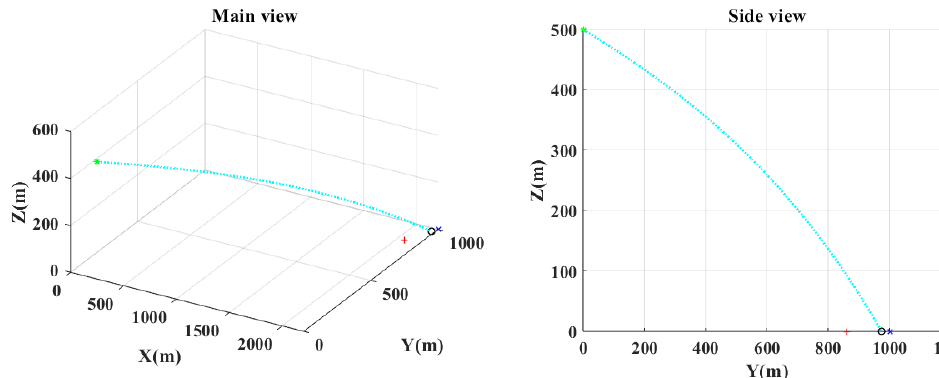
Figure 10. The ballistic of SID-IRL in case 1.